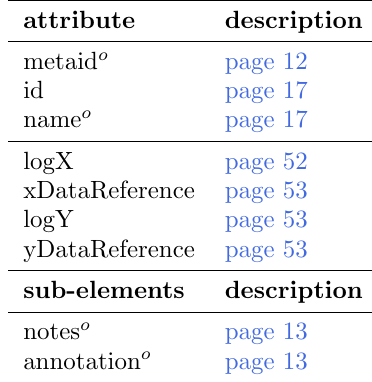
Listing 2.56 shows the use of the curve